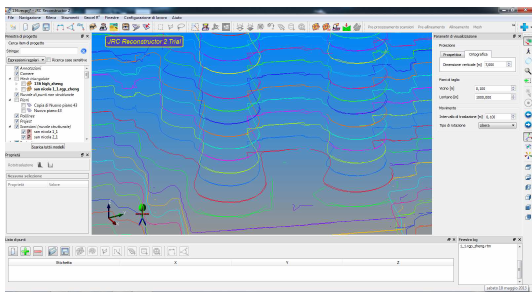
Figure 13: San Nicola façade mesh alignment error evaluation through horizontal cross sections 3.2.3